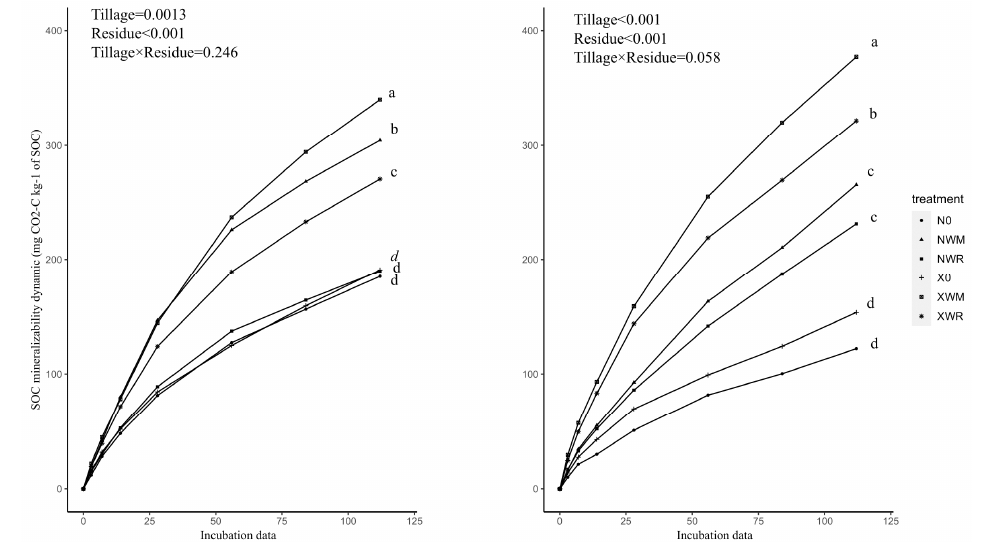
Figure 1. SOC mineralizability dynamics under different practices at 0–10 and 10–20 cm in the laboratory incubation (with straw addition). N0: no-tillage with no straw addition; NWR: no-tillage with wheat straw addition; NWM: no-tillage with maize and wheat straw addition; X0: rotary tillage with no straw addition; XWR: rotary tillage with wheat straw addition; XWM: rotary tillage with maize and wheat straw addition. Lower case letters indicate significant differences ( p < 0.05) among treatments within the same soil